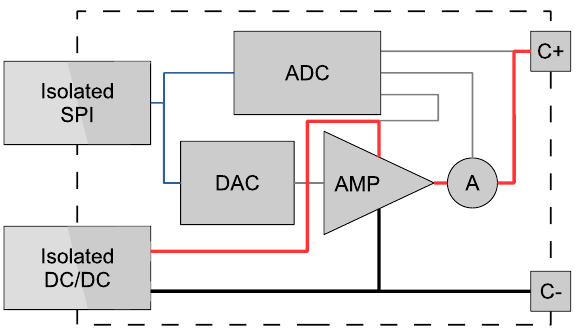
Figure 2. Architecture of the battery cell emulator described in this